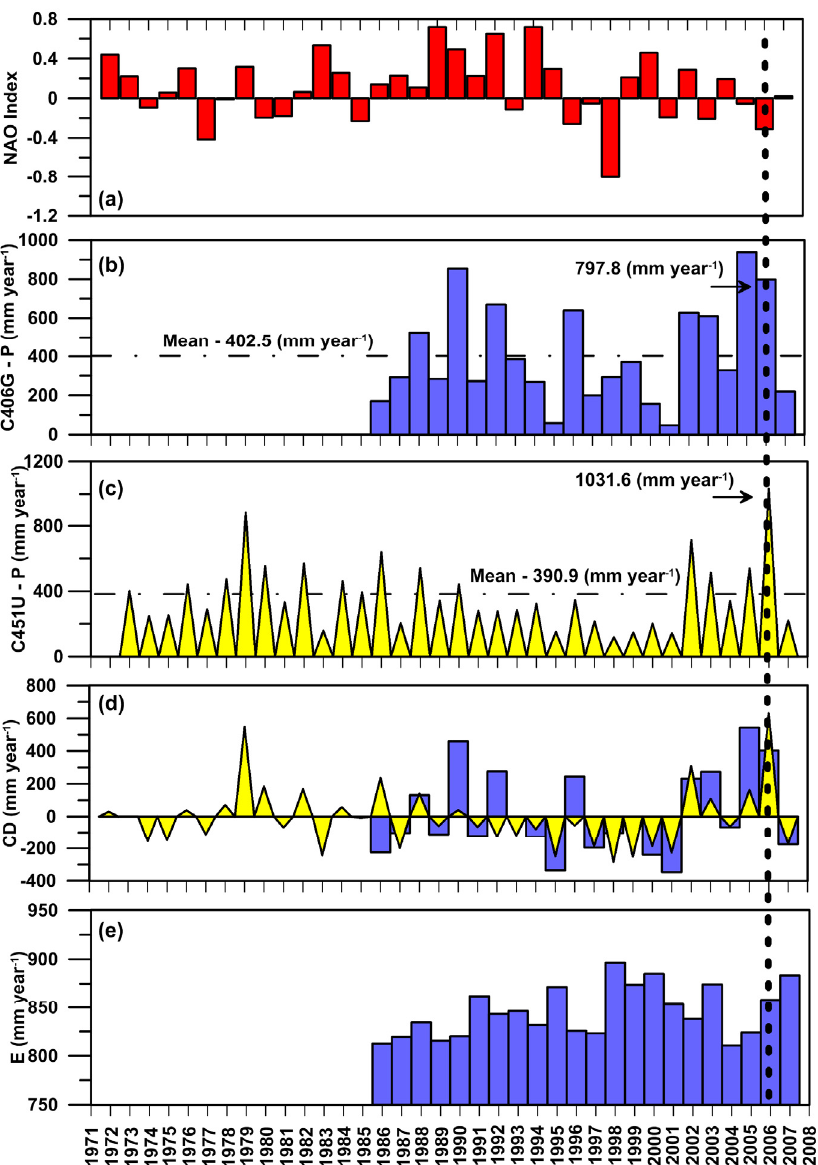
Figure 3. Hydrological regime in the LCC area from hydrological years 1971–1972 to 2007–2008. ( a ) Normalized North Atlantic Oscillation (NAO) index (NAO website: http://www.ncdc.noaa.gov/teleconnections/nao/); ( b ) yearly precipitation ( P , mm·year − 1 ) in C406G weather station at 2160 m a.s.l.; ( c ) yearly precipitation ( P , mm·year − 1 ) in C451U weather station at 2118 m a.s.l.; ( d ) cumulative deviation from average yearly precipitation ( CD , mm·year − 1 ) in C406G and C451U stations; and ( e ) yearly evapotranspiration ( E , mm·year − 1 ) in C406G station. Horizontal dashed lines correspond to average yearly precipitation in C406G and C451U stations. Vertical dashed line corresponds to yearly precipitation recorded in the year